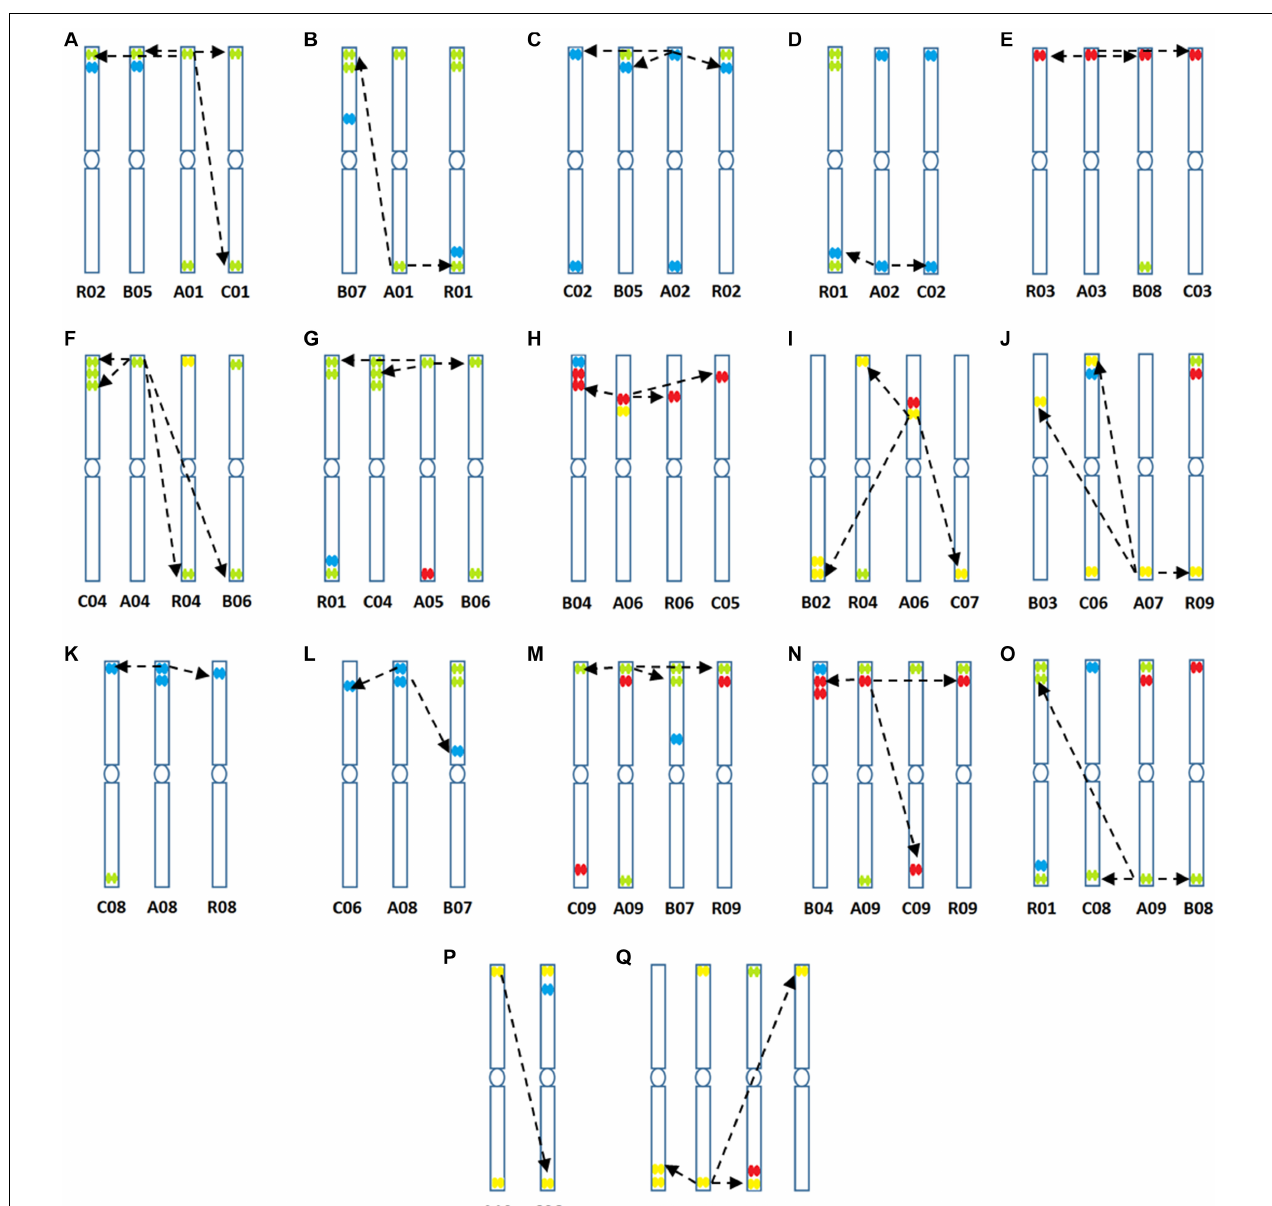
FIGURE 6 | (A–Q) Predicted structural chromosomal rearrangements among cultivated genomes of Brassica based on sequence data and locations of hybridization of the four oligonucleotide libraries.